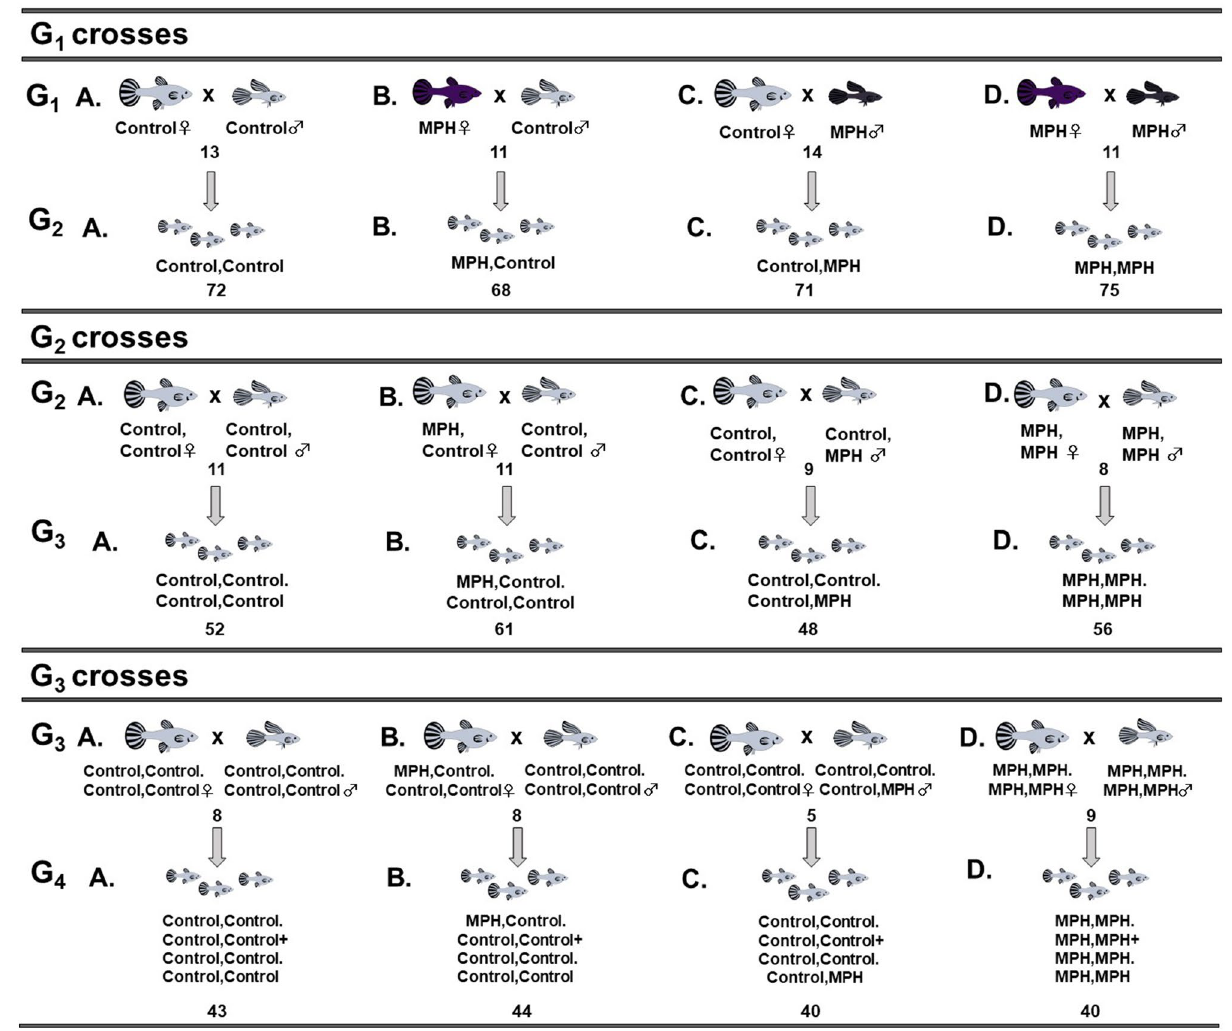
Figure 2. Crossing design for the G 2 -G 4 generations. First-generation fish were mated using a factorial design to produce four offspring (G 2 ) treatment groups: ( A ) Control female × Control male; ( B ) MPH treated female × Control male; ( C ) Control female × MPH treated male; and ( D ) MPH treated female × MPH treated male. These treatment lineages were maintained to produce the third (G 3 ) and fourth (G 4 ) generations. Because we saw an effect of MPH treatment on G 1 males, but not G 1 females, for statistical analyses of G 2 -G 4 cohorts, we pooled the original treatment groups into two categories: progeny that were descendants of (i) G 1 Control males (A. + B.) or (ii) G 1 MPH treated males (C. + D.). Numbers underneath pairs of fish represent the number of unique lines that contributed to the following generation. Numbers underneath the corresponding progeny groups (small fish) represent the sample size for that group in the open field test. In total, we measured the behaviour of 858 fish. Dark shading in G 1 fish represents MPH